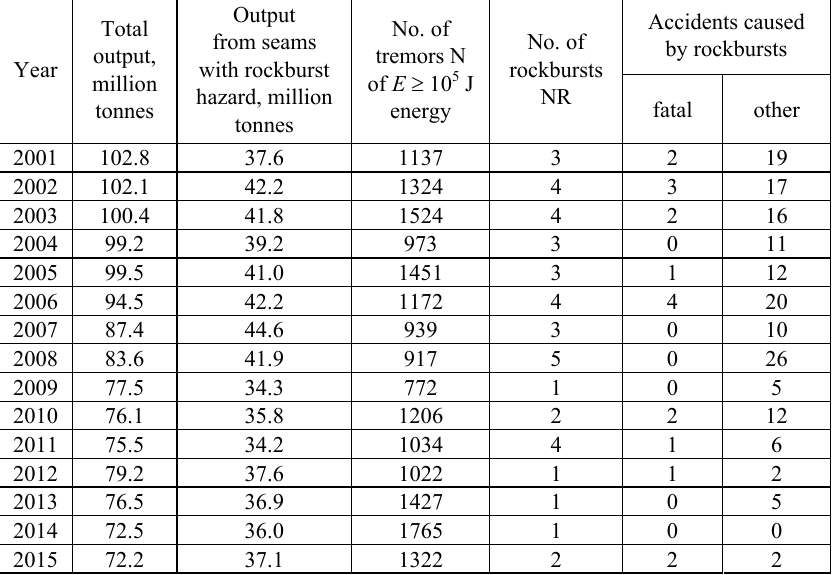
Table 3. List of coal extractions, number of high-energy tremors, number of rockbursts, and accidents in the mines of USCB between 2001 and 2015